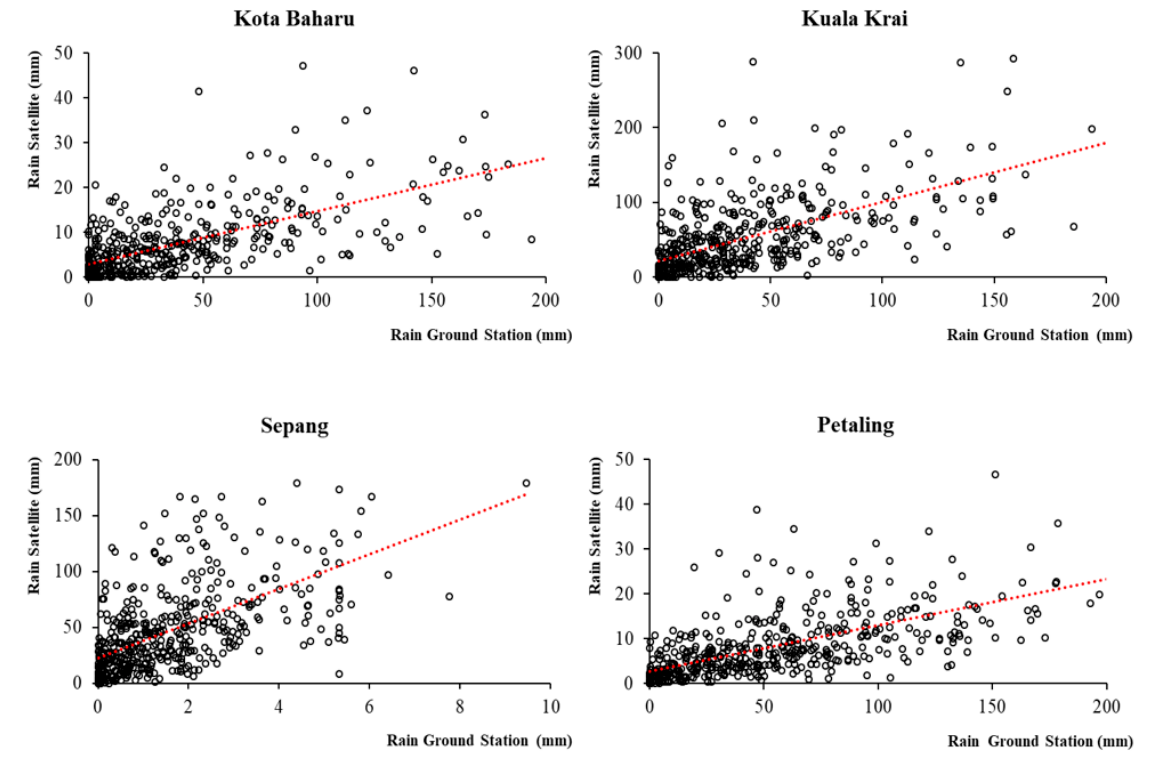
Figure 3. Correlation between rainfall data from EO and the four ground-based stations, 2011 to 2019, Malaysia.